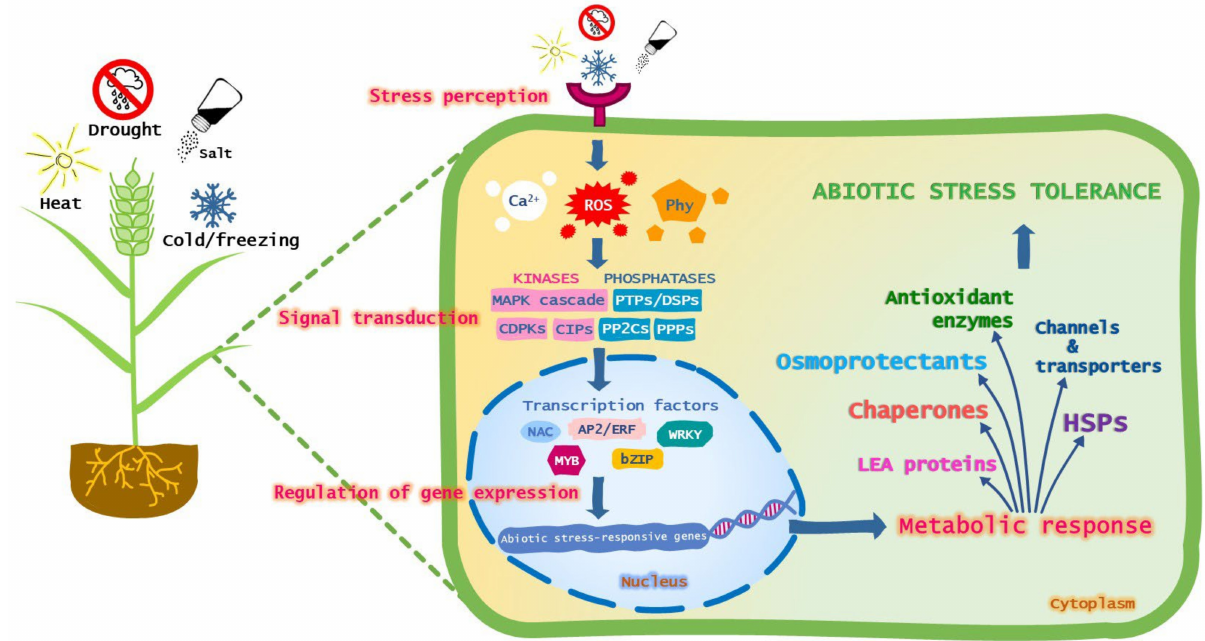
Figure 1. Schematic representation of the signalling pathway leading to the plant response to abiotic stresses. Specific receptors in the plasma membrane perceive the external stress signal and trans- mit the signal intracellularly through phytohormones and secondary messengers, such as calcium (Ca 2+ ) and reactive oxygen species (ROS). The second messengers activate different classes of protein kinases, including mitogen-activated protein kinase (MAPK) cascade, calcium-dependent protein kinases (CDPKs), and calcineurin-B-like proteins-interacting protein kinases (CIPKs), and protein phosphatases, such as protein tyrosine phosphatases/dual-specificity phosphatases (PTPs/DSPs), protein phosphatases 2C (PP2Cs), and serine/threonine-specific protein phosphatases (PPPs). Subse- quently, the protein kinases and phosphatases catalyze the phosphorylation/dephosphorylation of transcription factors, including APETALA2/ethylene response element-binding factors (AP2/ERF), the large NAC family, basic leucine zipper (bZIP), WRKY, and MYB. These finally regulate the expres- sion of abiotic stress-responsive genes encoding heat shock proteins (HSPs) and other chaperones, late embryogenesis abundant (LEA) proteins, enzymes involved in the biosynthesis of osmolytes, antioxidant enzymes and enzymes involved in the biosynthesis of small antioxidant molecules, aquaporins and ion transporters, which contribute to the tolerance of wheat to abiotic